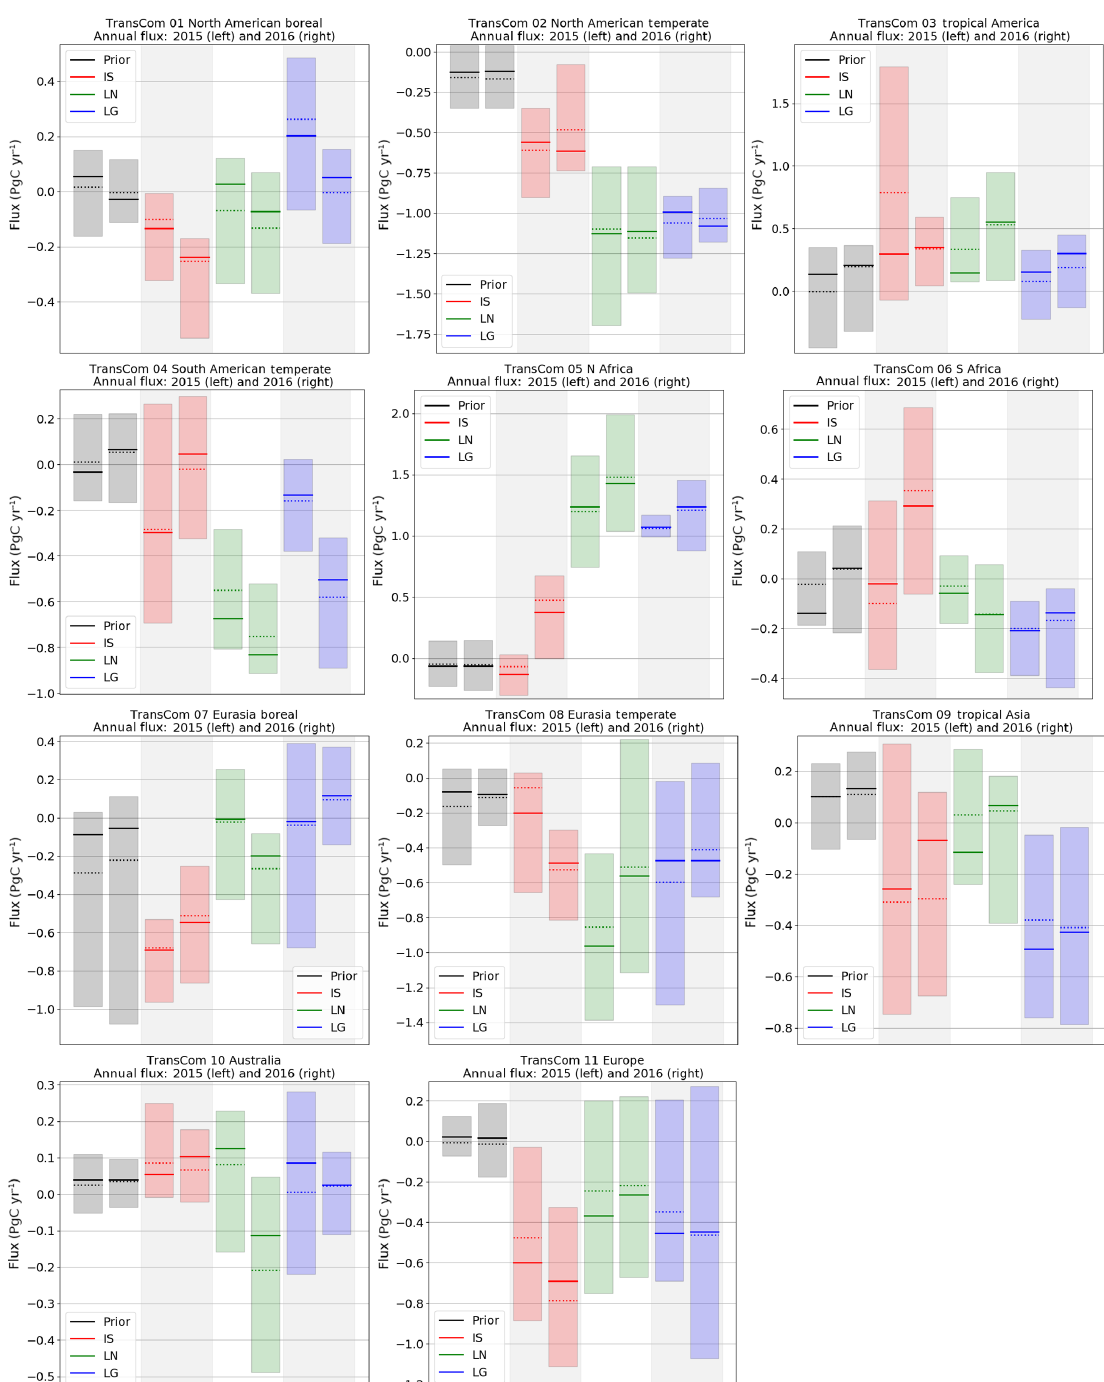
Figure B1. Ensemble annual fluxes for the 11 Transcom land regions. The bars each represent the trimmed range of the model ensemble posterior fluxes for 2015 (left bar) and 2016 (right bar). The solid line represents the median, and the dotted line represents the mean. The colors denote the prior fluxes (grey), as well as the posterior fluxes constrained by in situ (IS, red), land nadir (LN, green), and land glint (LG, blue)